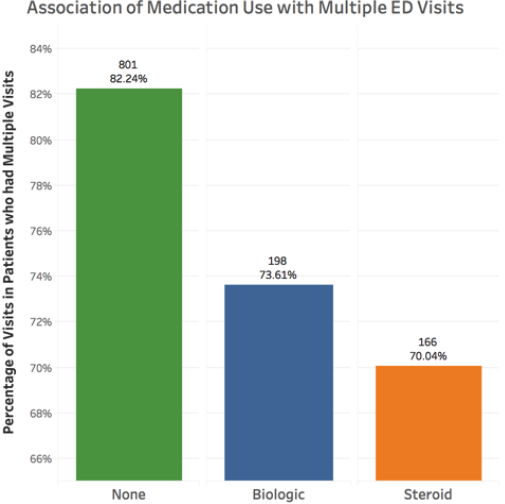
Figure 4. Association of medication use with visits in patients with multiple ED visits. There was a decreased likelihood of multiple ED visits with biologic use ( p = 0.023, coefficient − 0.055) or if patients were previously taking steroids for IBD ( p = 0.0005, coefficient −